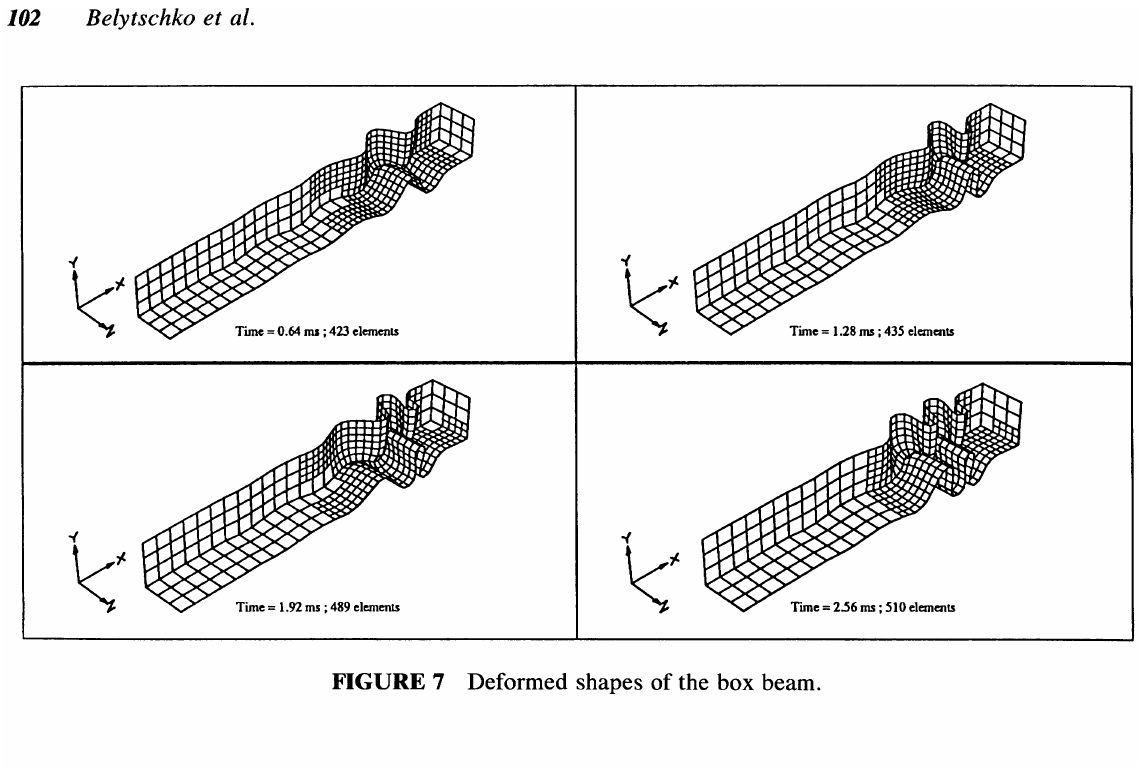
FIGURE 7 Deformed shapes of the box beam.